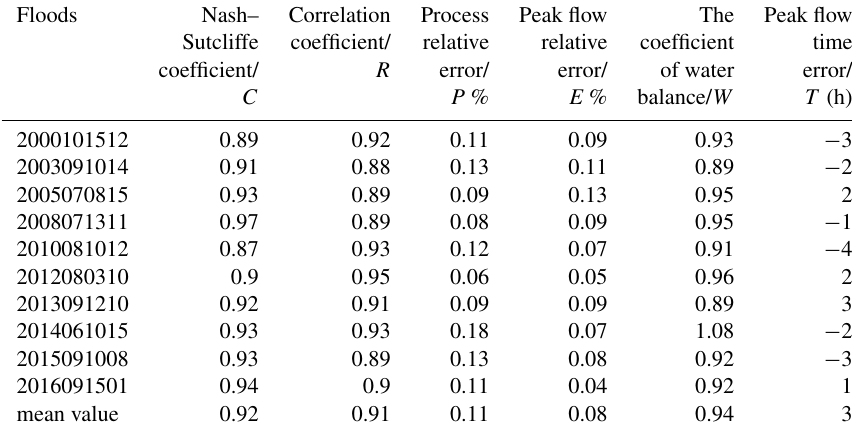
Table 6. The evaluation indices of the simulated flood results based on the Liuxihe model in the Beijiang catchment.